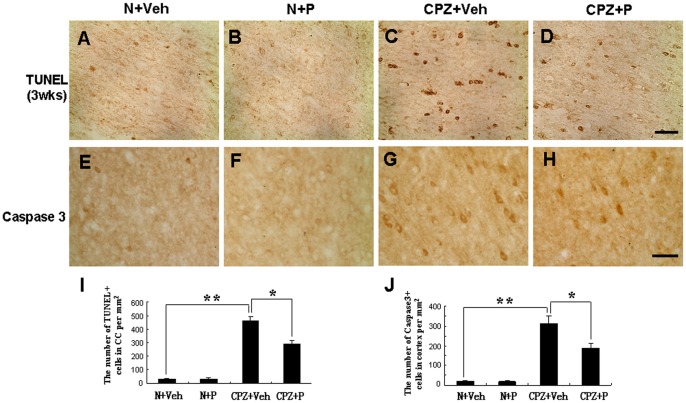
Progesterone rescued the loss of TUNEL-positive cells in the corpus callosum and Caspase3-positive cells in the corpus callosum of cuprizone-induced mice.TUNEL-positive cells were observed in the corpus callosum at 3 weeks in the N+Veh (A), N+P (B), CPZ+Veh (C), and CPZ+P group (D). (E) Statistical analyses showed that TUNEL-positive cells decreased in the CPZ+P group compared with the CPZ+Veh group. Bar = 50 µm. Caspase3-positive cells were observed in N+Veh group (F), N+P group (G), CPZ+Veh group (H), and CPZ+P group (I) in the cortex of mice. (J) Statistical analyses showed that Caspase3-positive cells decreased in the CPZ+P group compared with the CPZ+Veh group. Bar = 50 µm. *CPZ+P vs. CPZ+Veh group, P<0.05; **CPZ+Veh vs. N+Veh group, P<0.01.